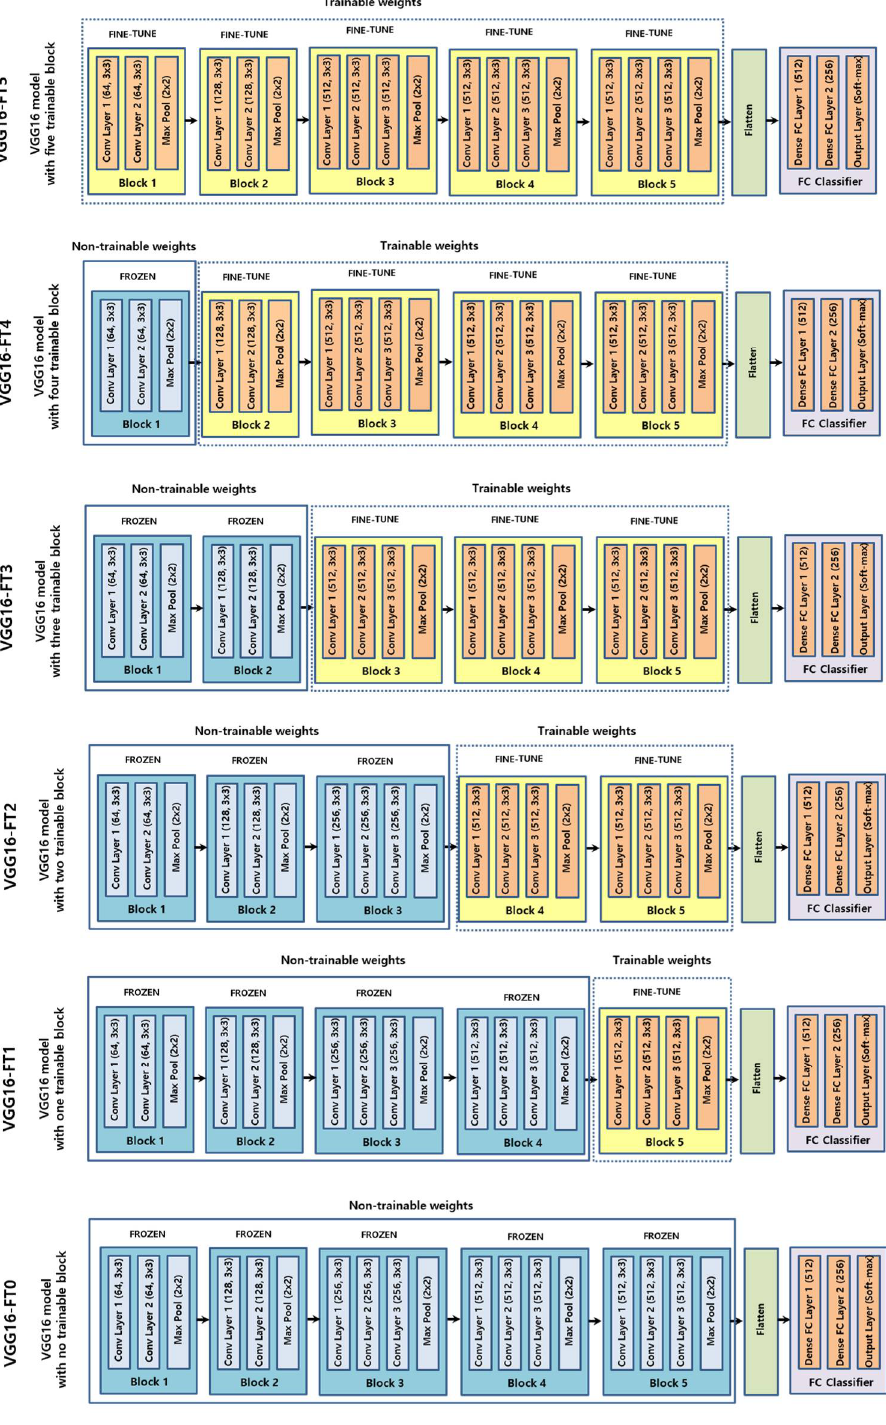
Figure 3. Schematic diagram of six experimental groups based on fine-tuning degree in VGG-16 backbone convolutional neural network (CNN).